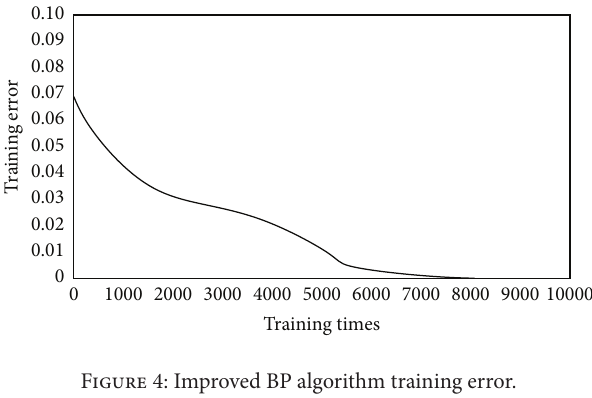
Figure 4: Improved BP algorithm training error.